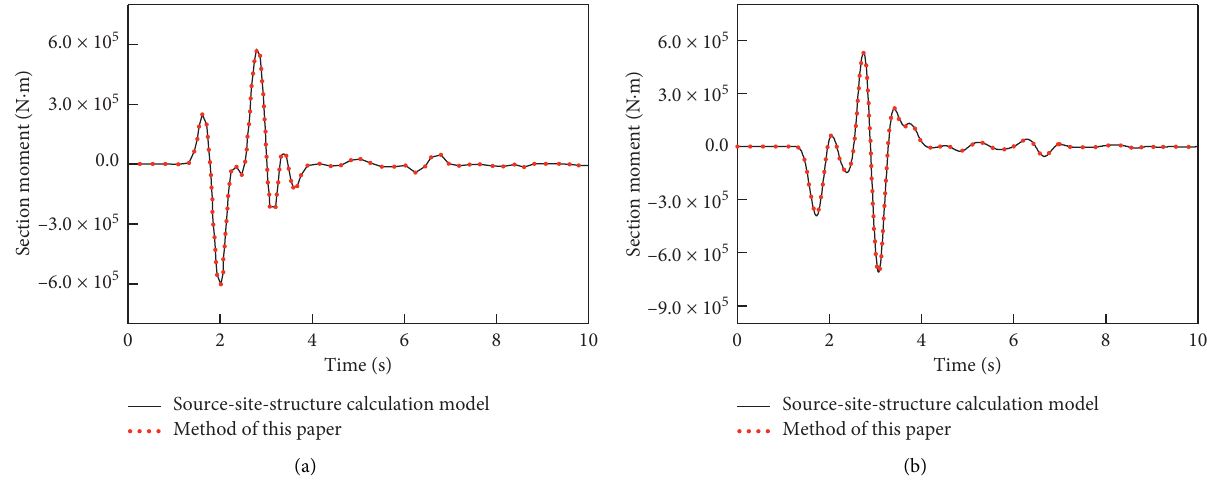
Figure 17: Comparison of the bending moment values of the structural section (burial depth is 200m): (a) section (A), (b) section C.